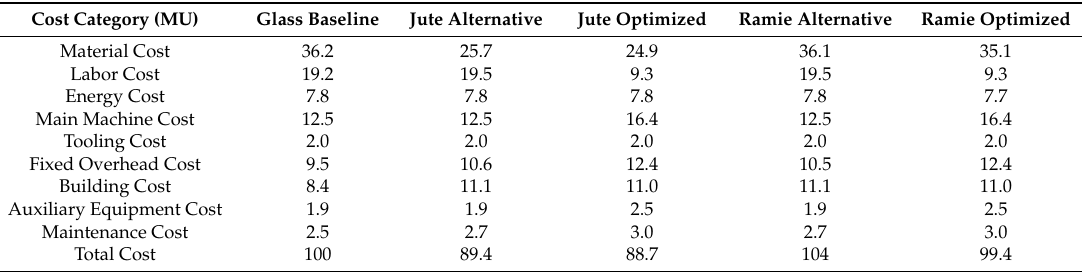
Table 8. Cost breakdown per hood part for all scenarios.